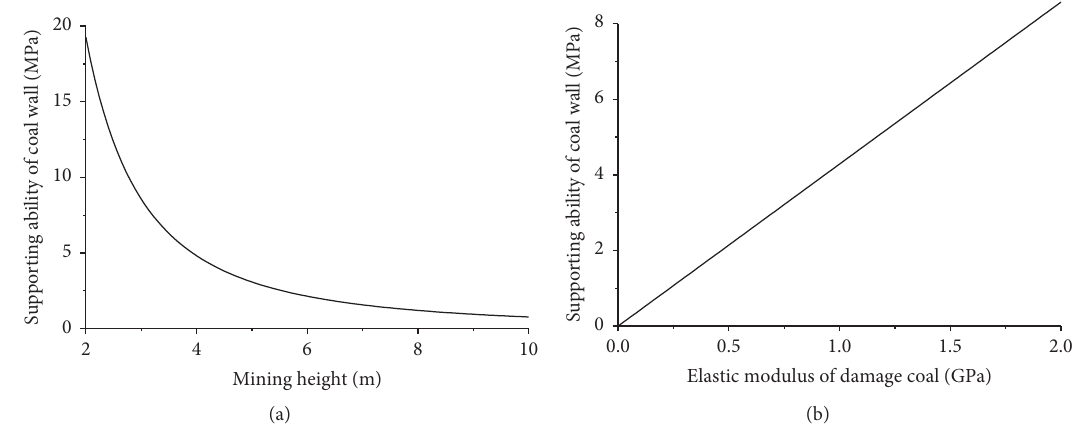
Figure 9: Influence factors of coal wall supporting ability. (a) The influence of the mining height ( E elastic modulus of coal ( M � 6.0